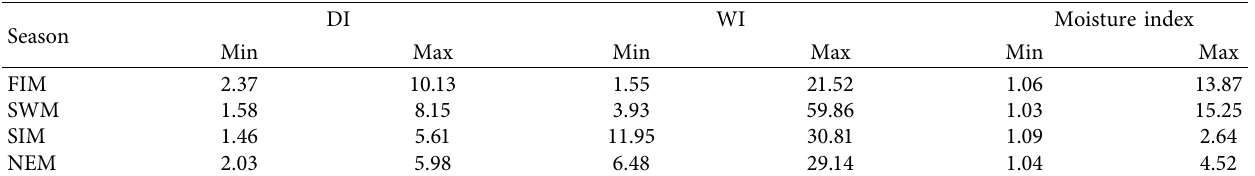
Figure 2: Historical indices from observed climatic parameters (1990–2004). (a) For normalized DI. (b) For normalized WI. (c) Moisture index. Table 2: Indices for historical meteorological